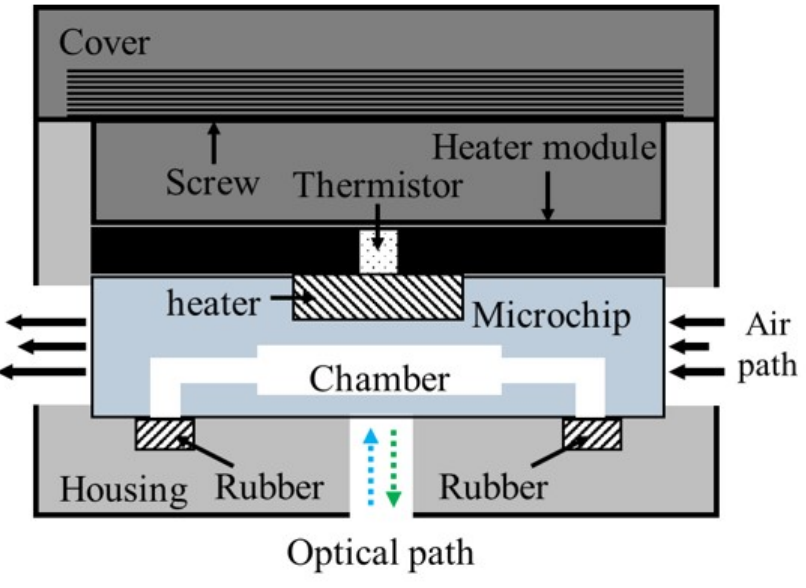
Figure 3. Schematic of the thermocycler